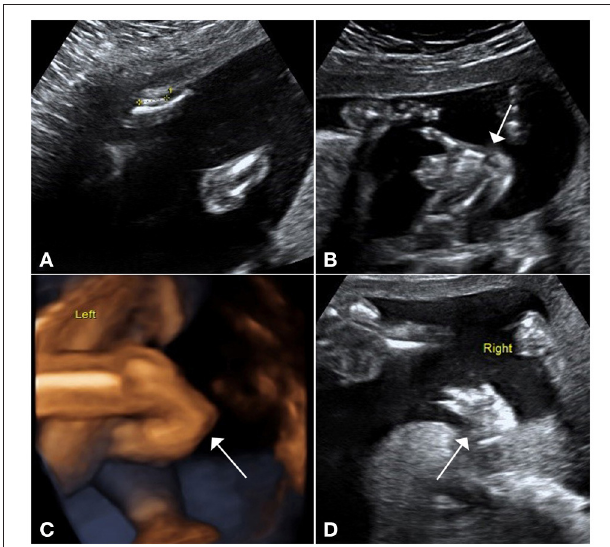
FIGURE 1 | Ultrasound pictures demonstrate upper-limb malformations. (A) Ultrasound demonstrates shortness of the radius and ulna, especially the radius. (B) Ultrasound and (C) 3D views show that the hands had the inability to supinate. (D) Right thumb was missing in ultrasound imaging.